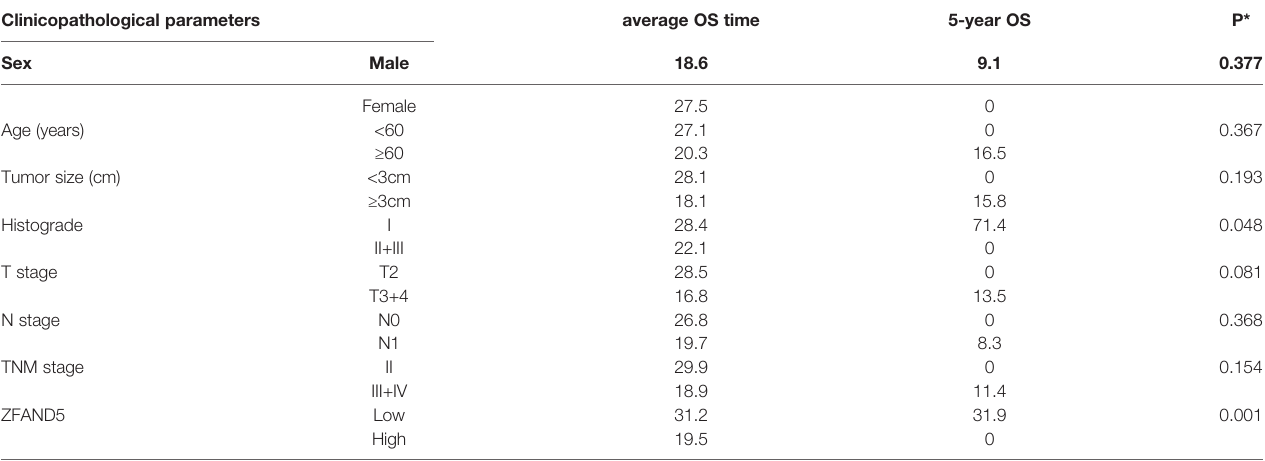
TABLE 3 | The prognostic signi fi cance in univariate analysis.